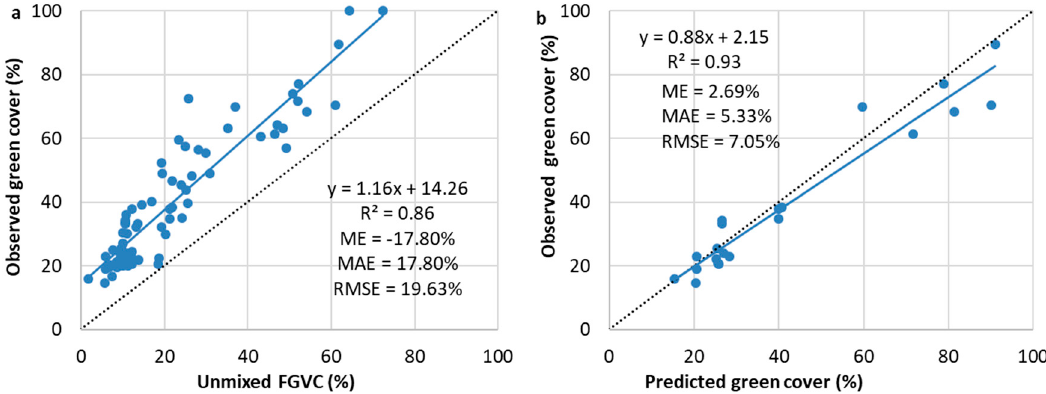
Figure 8. The relationship between unmixed green fraction and 70% of observed green vegetation cover ( a ), and the relationship between predicted green vegetation cover and the remaining 30% of observed green vegetation cover ( b ).